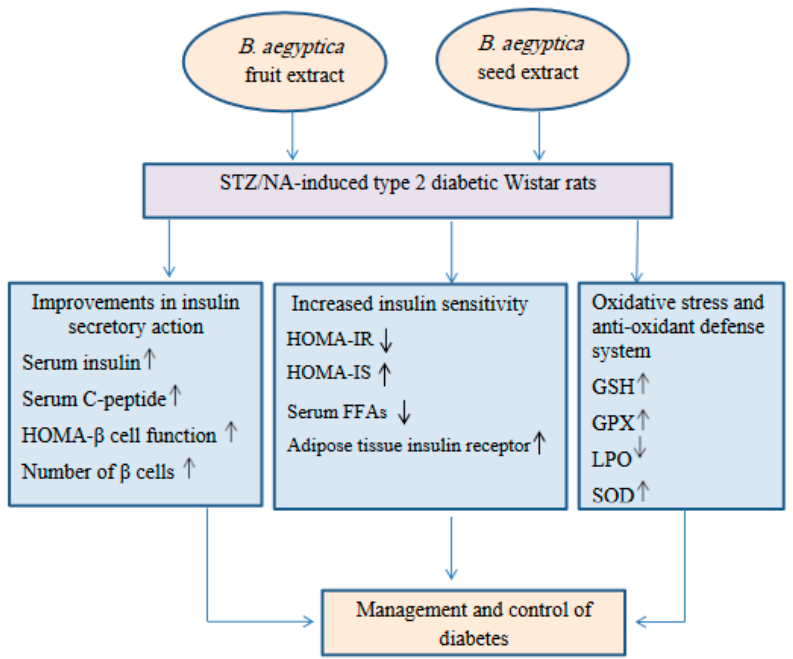
Figure 6. Schematic illustrative figure depicting the suggested hypothesis of the modes of action of the B . aegyptiaca fruit and seed aqueous extracts.